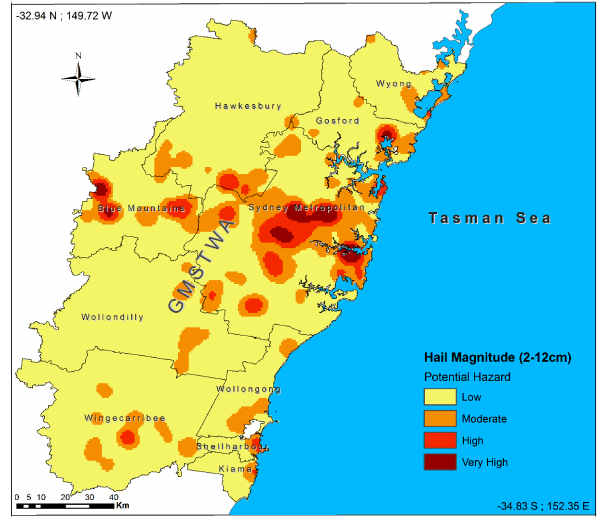
Figure 13. A raster-based hail magnitude density model inside of the